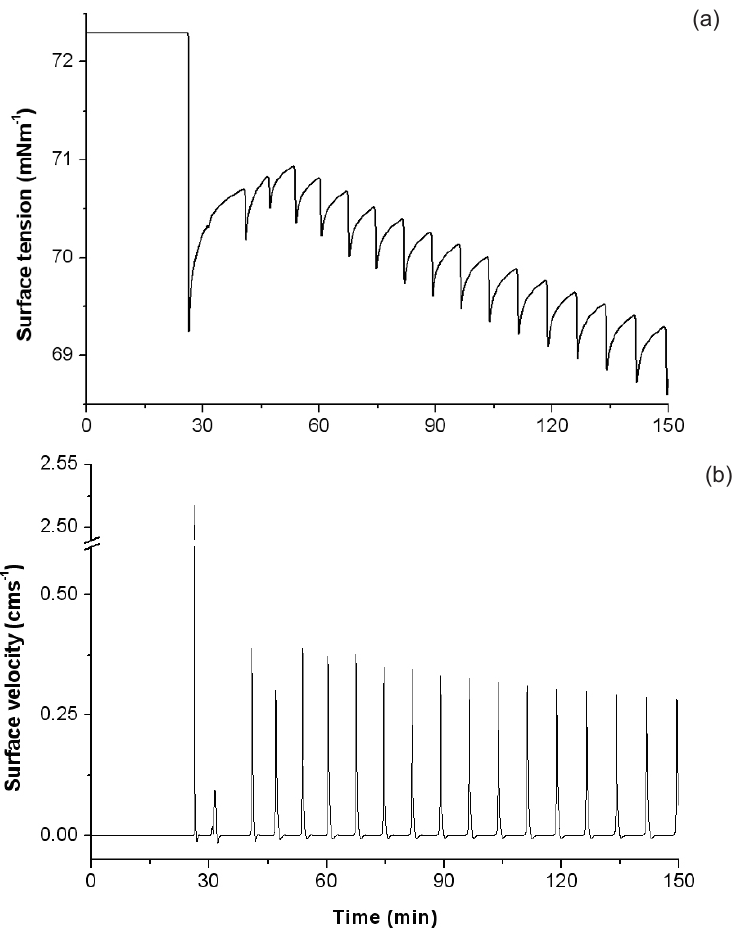
Figure 8. Results of numerical simulation on dissolution of a hexanol droplet u nder the air/water interface: vessel diameter d=40 mm, capillary immersion depth h=8 mm, buoyancy is neglected; a) surface tension vs time, b) surface velocity vs time (reprinted from [43], with permission from American Physical